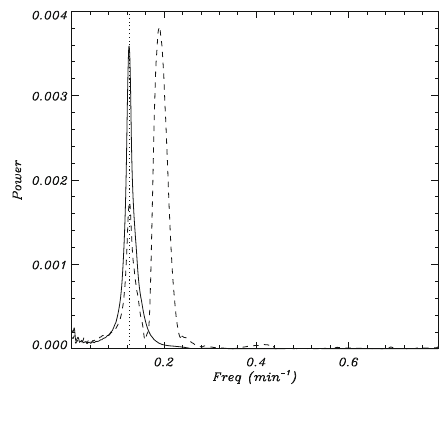
Fig. 71 Detail of the prominence (in red–orange) together with some magnetic field lines and the locations where the kinetic energy increases (in yellow) as a result of resonant damping. The simulation parameters are the same as in Fig. 70. Image reproduced with permission from Terradas et al. (2016), copyright by AAS